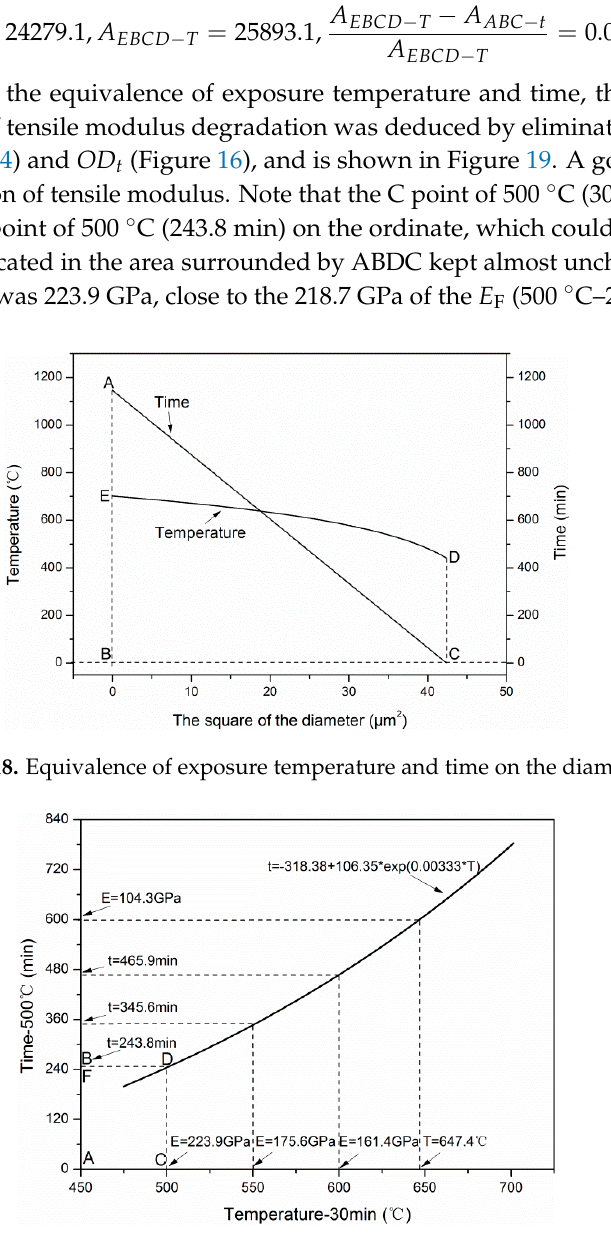
Figure 17. Time–temperature equivalence on the radial distribution of tensile modulus .